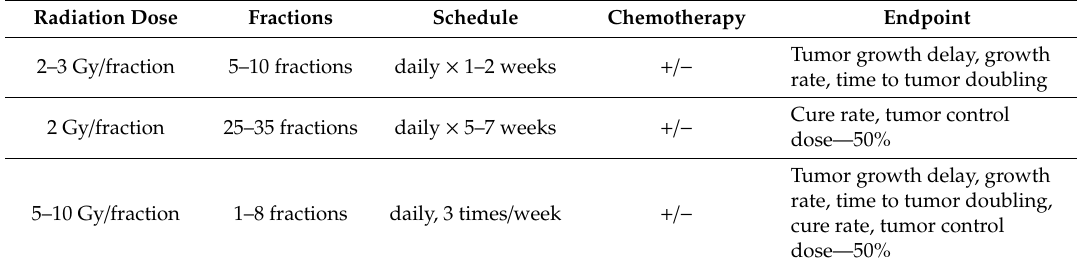
Table 1. Common radiation doses, fractionation schemes and measured